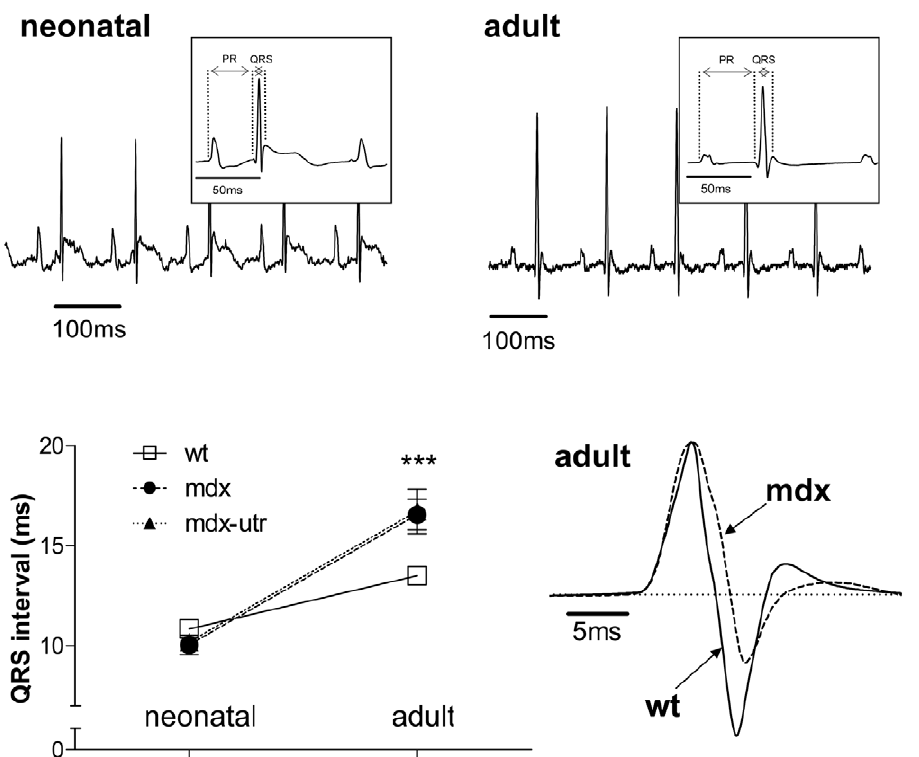
Figure 5. Surface ECG recordings on wt and dystrophic neonatal and adult mice. (Top) Typical original ECG signals (lead 1) from neonatal and adult wt mice, and the corresponding averages over 100 beats (insets). (Bottom right) Overlay of representative QRS-complexes (lead 2) in adult wt and mdx mice. In the graph, the QRS intervals of neonatal and adult ECGs are compared between wt and dystrophic mice. *** significant difference (ANOVA, p , 0.001, n-values: 6–15) between the three tested groups. No significant differences exist between mdx-utr and mdx.